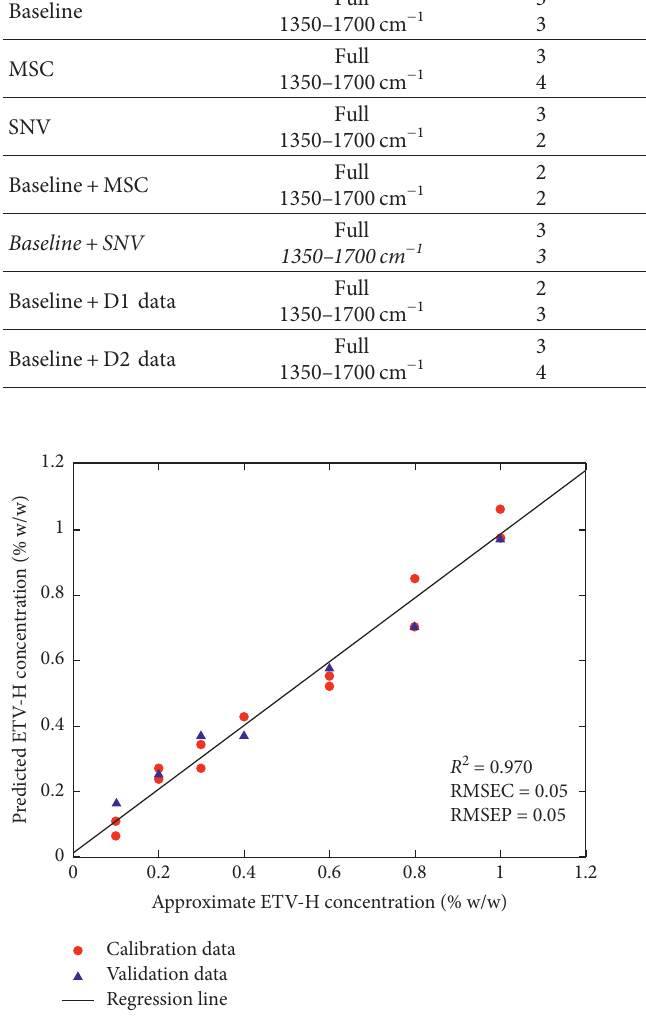
Figure 5: Approximate vs. predicted ETV-H concentrations in calibration set samples and validation set samples obtained by the best performance PLS models (baseline correction and the SNV method for data pretreatment in the wave number range of 1350–1700cm − 1 ). Despite a long mixing process, the homemade tablets still could not obtain a uniform content, so it was impossible to obtain the exact concentration of ETV-H in each tablet. Ap- proximate ETV-H concentration referred to the approximate value of the real ETV-H concentration.